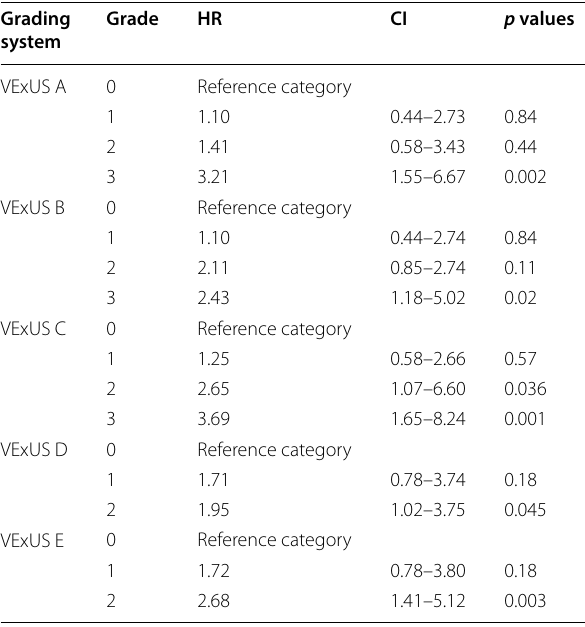
Proportional hazard regression models (Cox) with VExUS grading systems considered as time varying covariates (i.e., VExUS grade at day 0 is used to predict acute kidney injury (AKI) at day 1, VExUS grade at day 1 is used for AKI at day 2 and so on). HR hazard ratio, CI 95% confidence intervals)